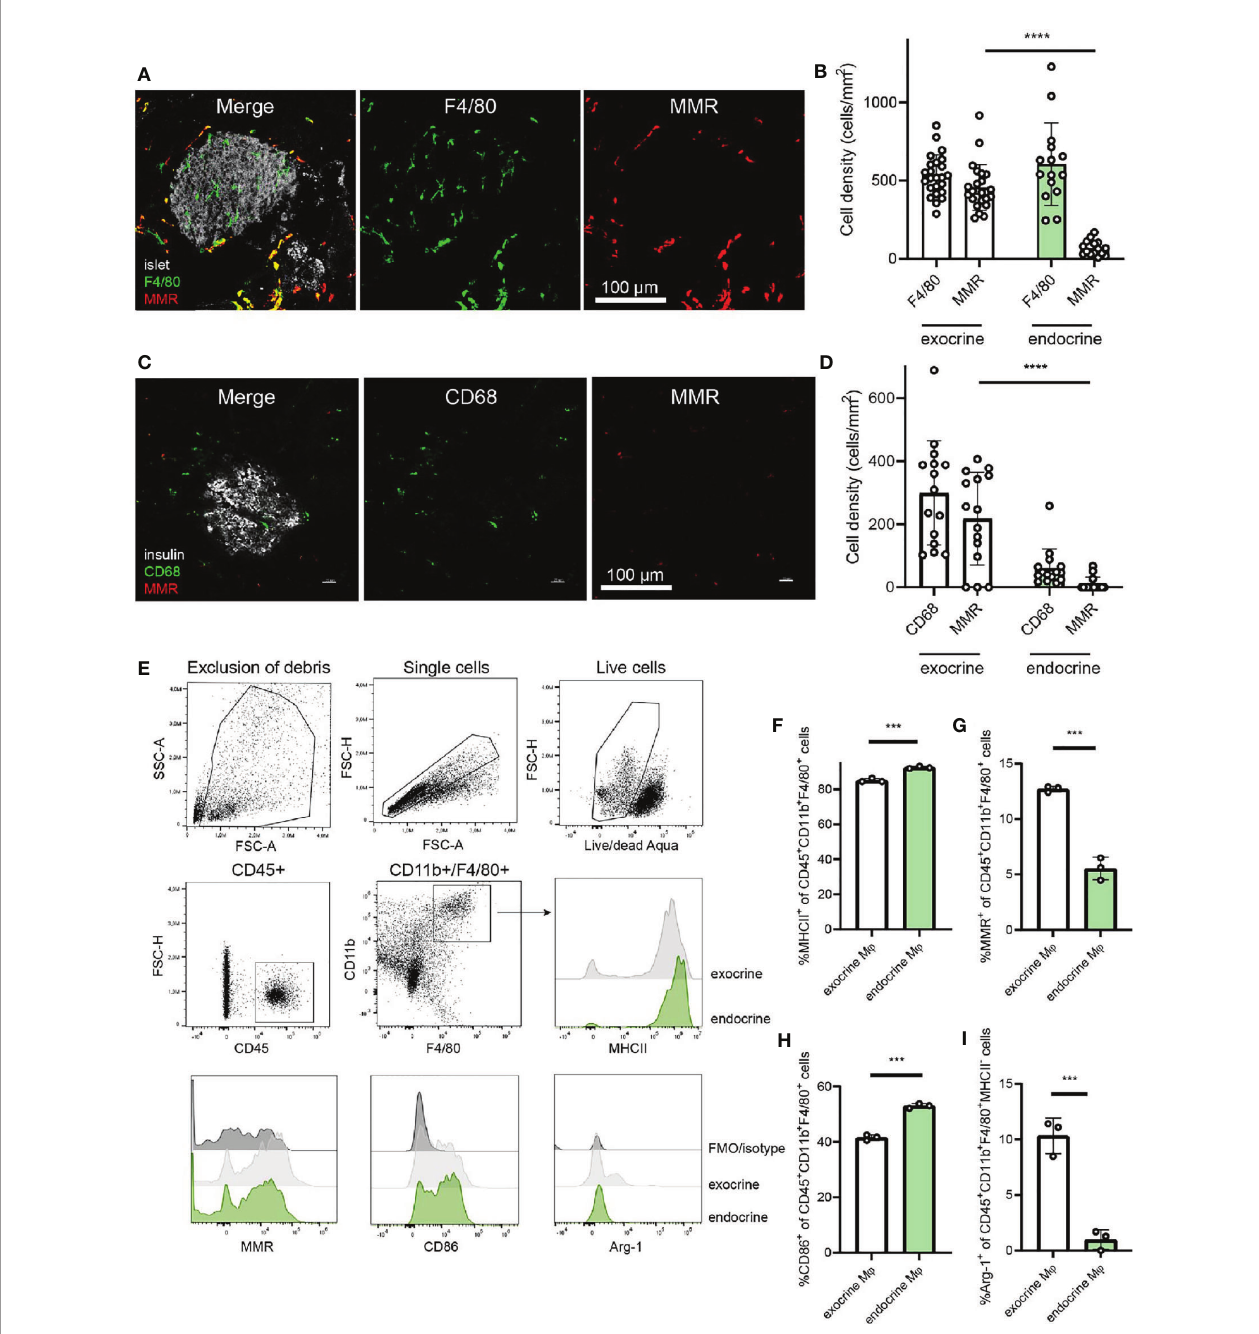
FIGURE 1 | Endocrine-resident macrophages are skewed to an in fl ammatory phenotype. (A) Immuno fl uorescence of the mouse pancreas reveals total absence of the mannose receptor (MMR) in endocrine-resident macrophages, whereas exocrine-resident macrophages express this receptor to a large extent (islets in grey, laser re fl ection, pan-macrophage marker F4/80 in green, MMR in red). (B) Quanti fi cation of immuno fl uorescence stainings for the pan-macrophage marker F4/80 and MMR in the pancreas showed that more than 90% of macrophages in the exocrine tissue expressed MMR and only a few percent of the endocrine-resident macrophages did (n=9 mice, 15 islets, 24 exocrine regions, ****P < 0.0001, Mann-Whitney U test). (C) Representative image of staining human pancreata for CD68 (green), MMR (red), and insulin (grey) (D) The expression of MMR in macrophages in human endocrine tissue was found to be lower than for macrophages in the exocrine tissue (n=3 donors, ****P < 0.0001, Mann-Whitney U test). (E) Gating strategy for endocrine- and exocrine-resident macrophages from mouse pancreas, including representative fl ow histograms of MHCII, MMR, CD86, and Arg-1 expression (representative of three independent experiments). (F) Endocrine-resident macrophages expressed signi fi cantly more MHCII, (G) signi fi cantly less MMR, (H) signi fi cantly more CD86, and (I) signi fi cantly less Arg-1 (of MHC-II - populations) than exocrine-resident macrophages (***P < 0.001, Mann-Whitney U